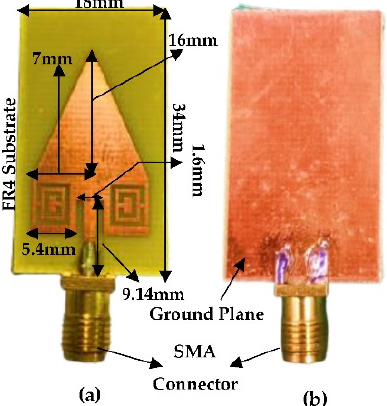
Figure 14. Fabricated structure of proposed antenna with complete ground plane ( a ) Top Layer ( b ) Bottom Layer.